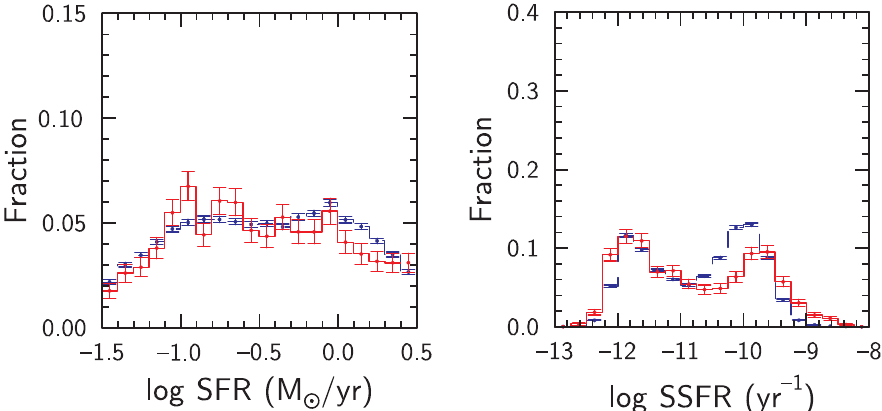
Fig. 3. SFR and SSFR distributions for the pair subsample and the control sample. Designations are the same as in Figure 1.